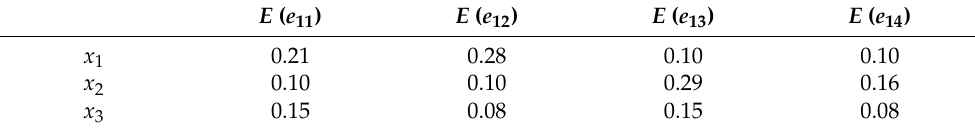
Table 3. Entropy of each parameter of hydrological and climatic conditions B 1 at time t 3